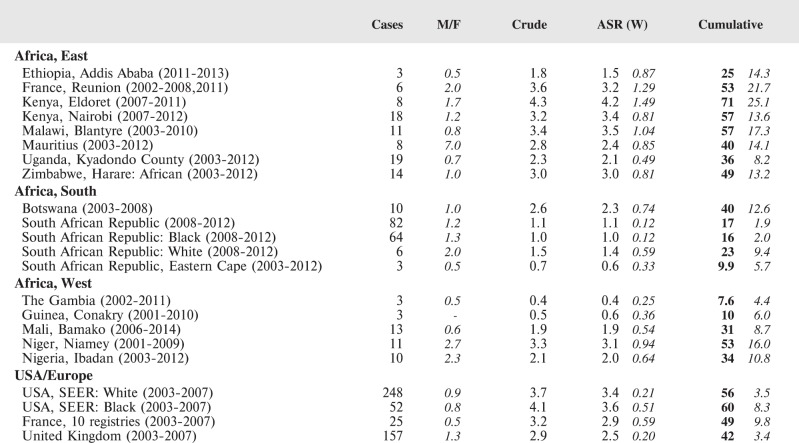
Crude, age-standardised (world) and cumulative (0–14) incidence rates (per million) and standard errors— osteosarcoma.